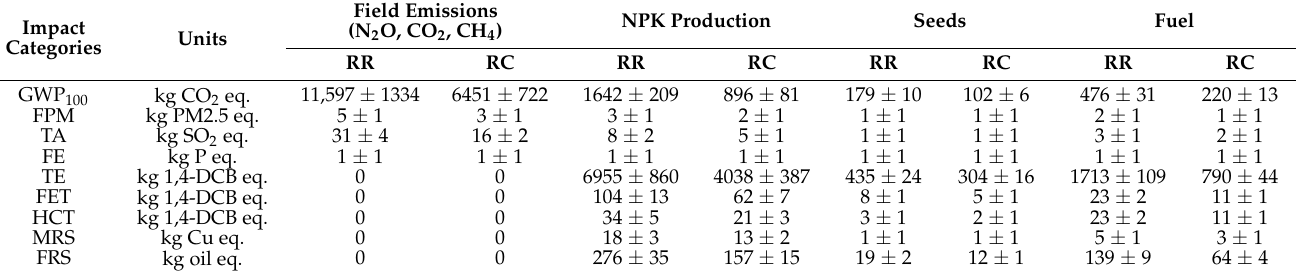
Table 5. Emissions from different major inputs to different impact